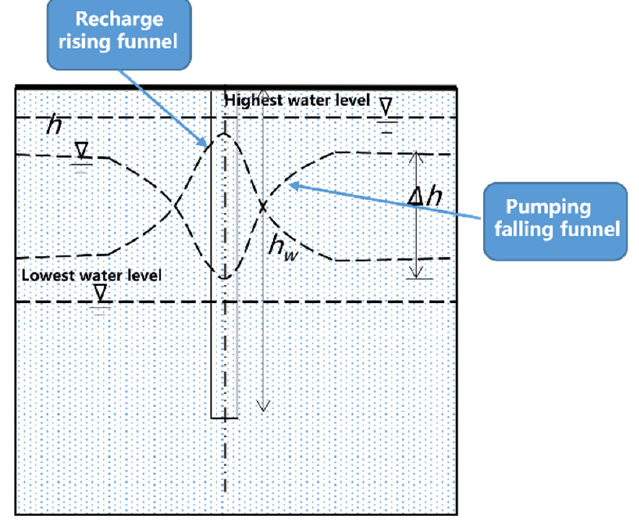
Figure 4. Falling funnel and rising funnel of the well.